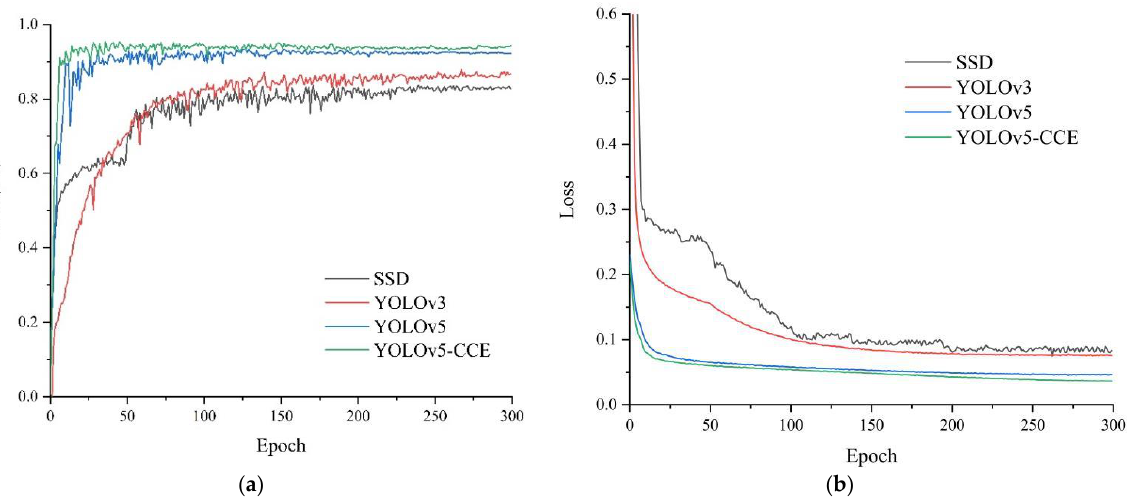
Figure 8. Detection results of two models. ( a ) Pre-tapping, ( b ) One-year tapping age, ( c ) Three-year tapping age, ( d ) Five-year tapping age.